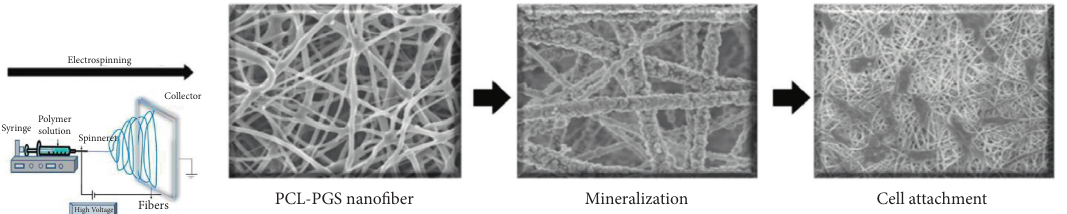
Figure 1: Preparation of nanofibers with the electrospinning method and the osteogenesis in vitro process; reproduced from [33], with permission from